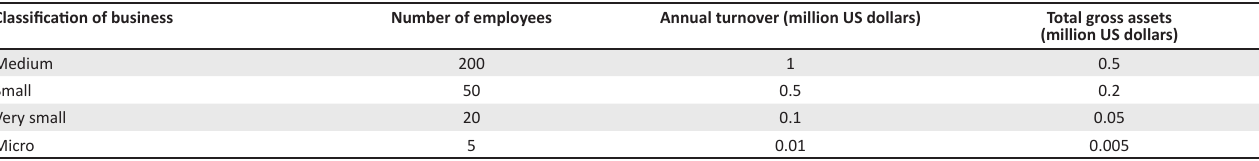
TABLE 1 -A1: The small business quantities in context with smaller and larger business. Classification of